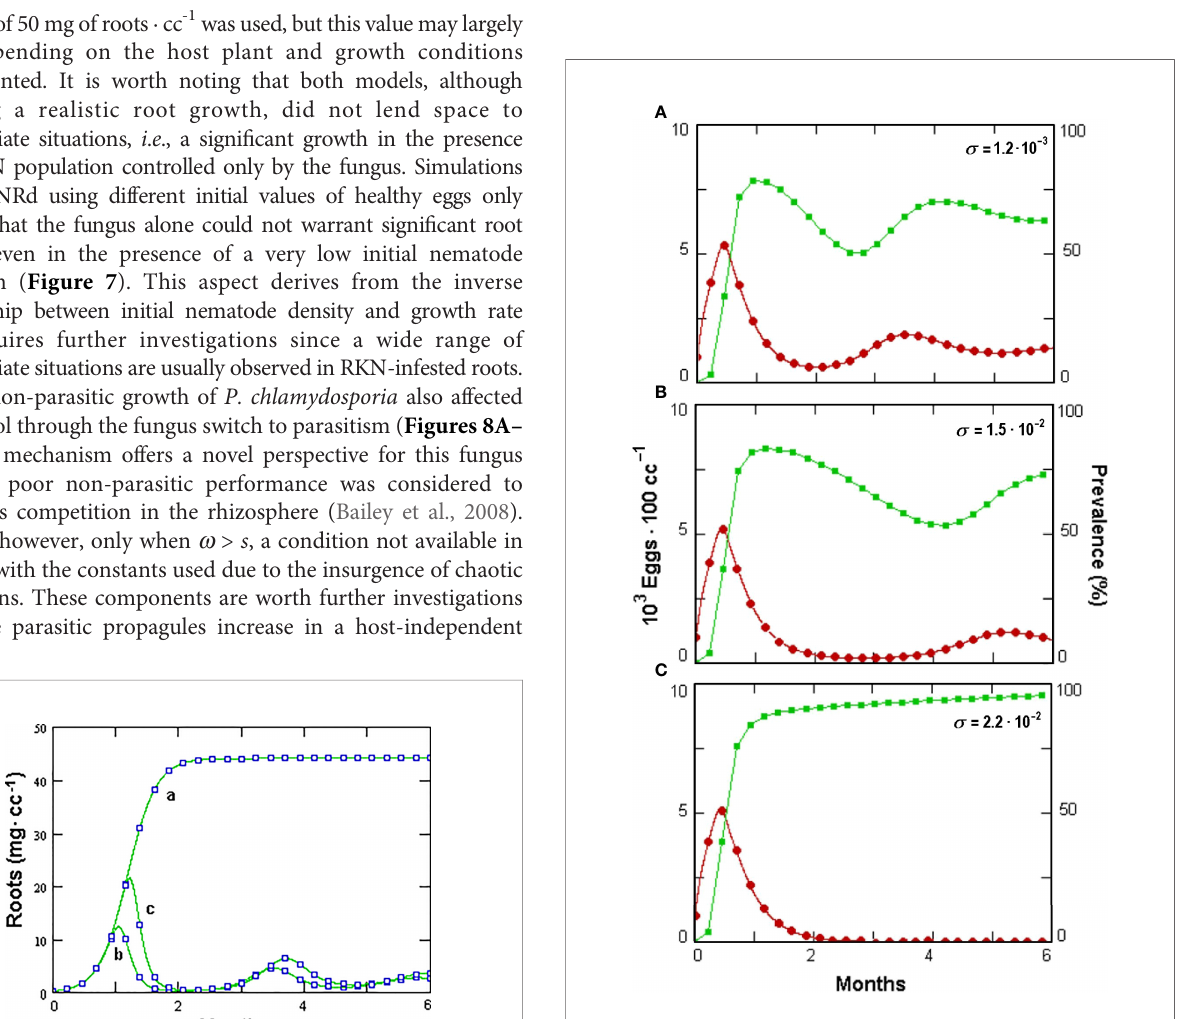
FIGURE 8 | Effect (A – C) of increasing Pochonia chlamydosporia non- parasitic growth rate ( s , insets) on prevalence (green squares) and Meloidogyne incognita egg densities (red dots) as simulated by GPNRd, showing host extinction at highest s (see Table 1 for the initial values of the